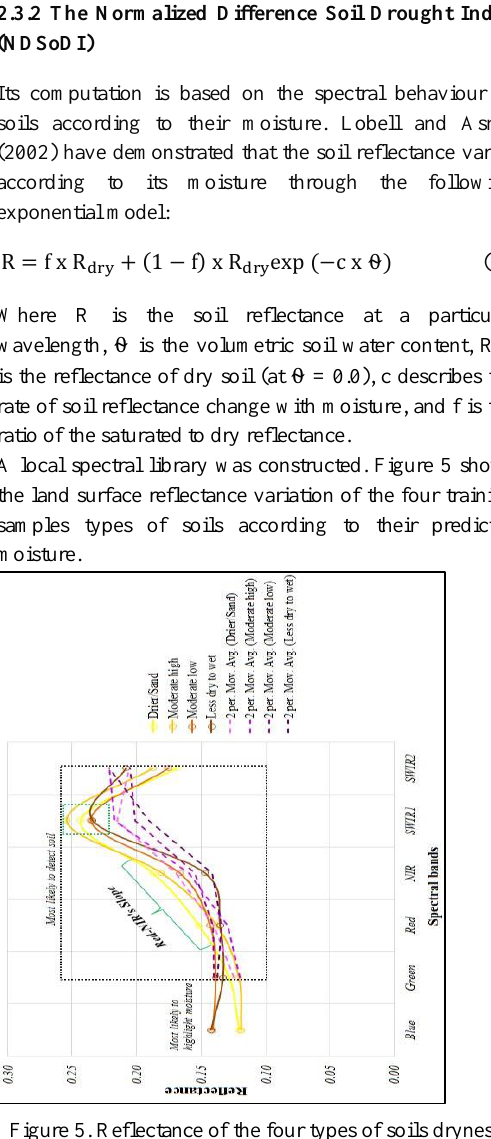
Figure 7. Reflectance curves for April